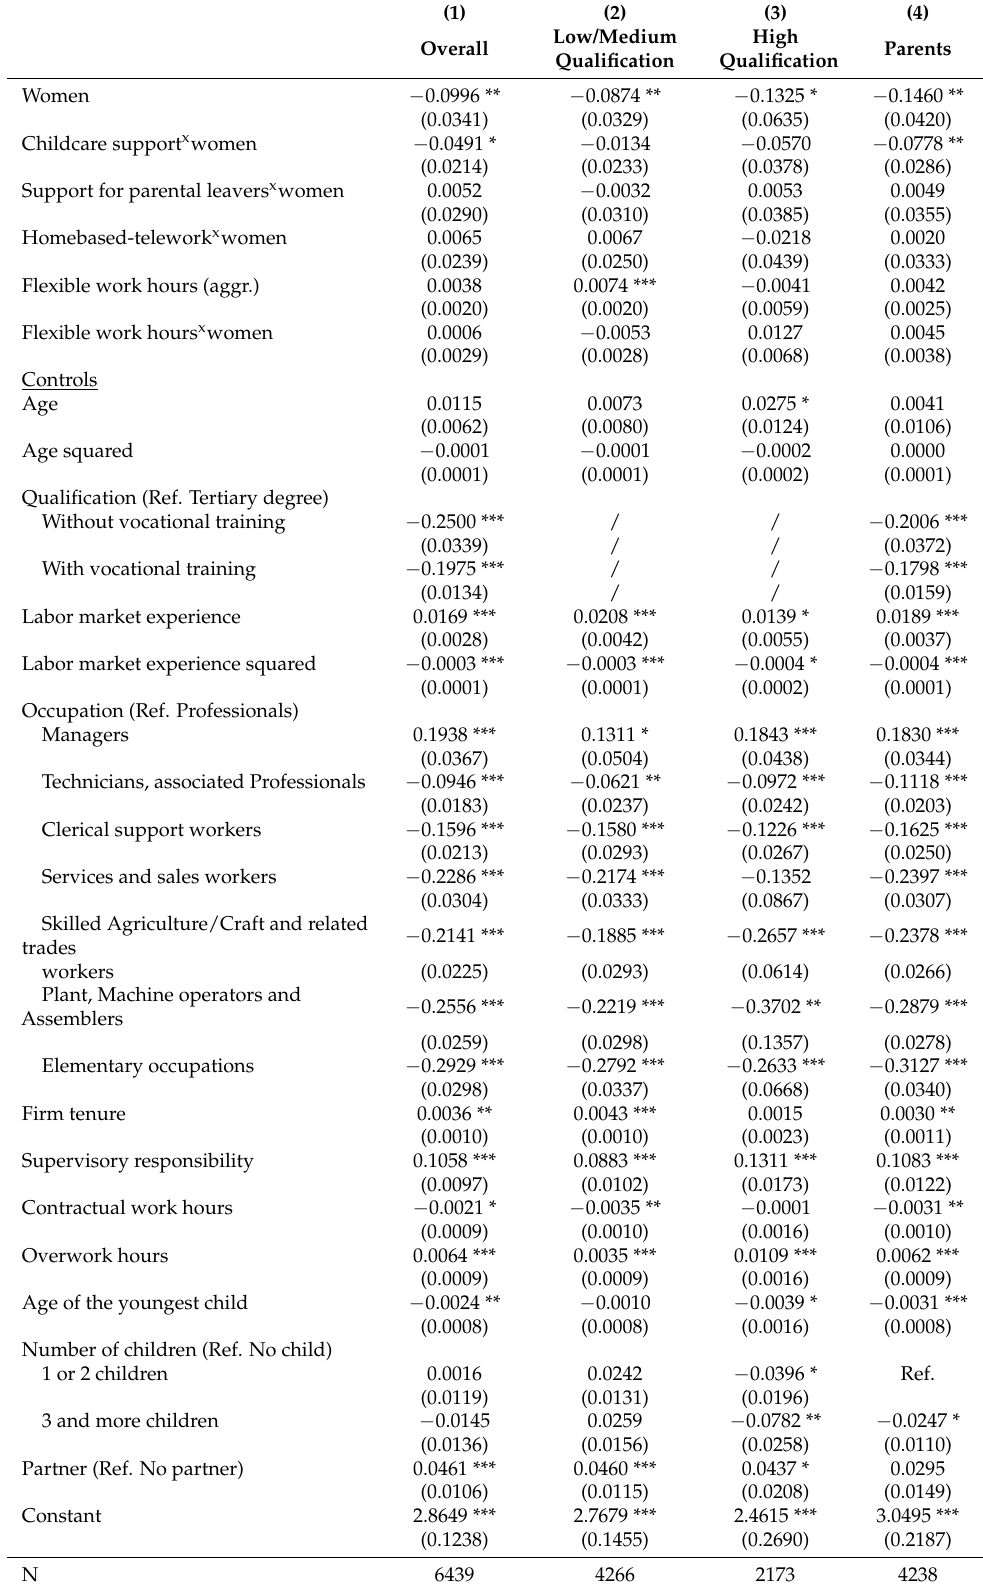
Table A5. The association of work–life measures and log hourly wages including controls (extended version of Table 3, step